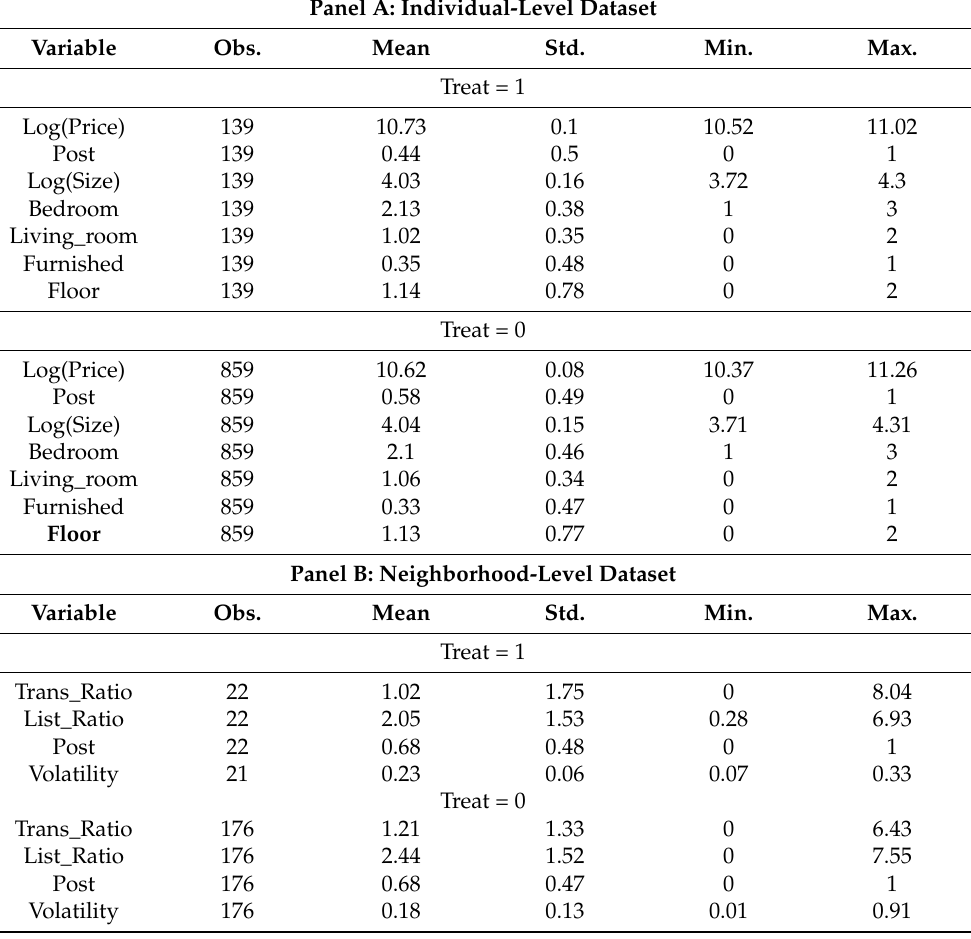
Table 2. Descriptive statistics of the